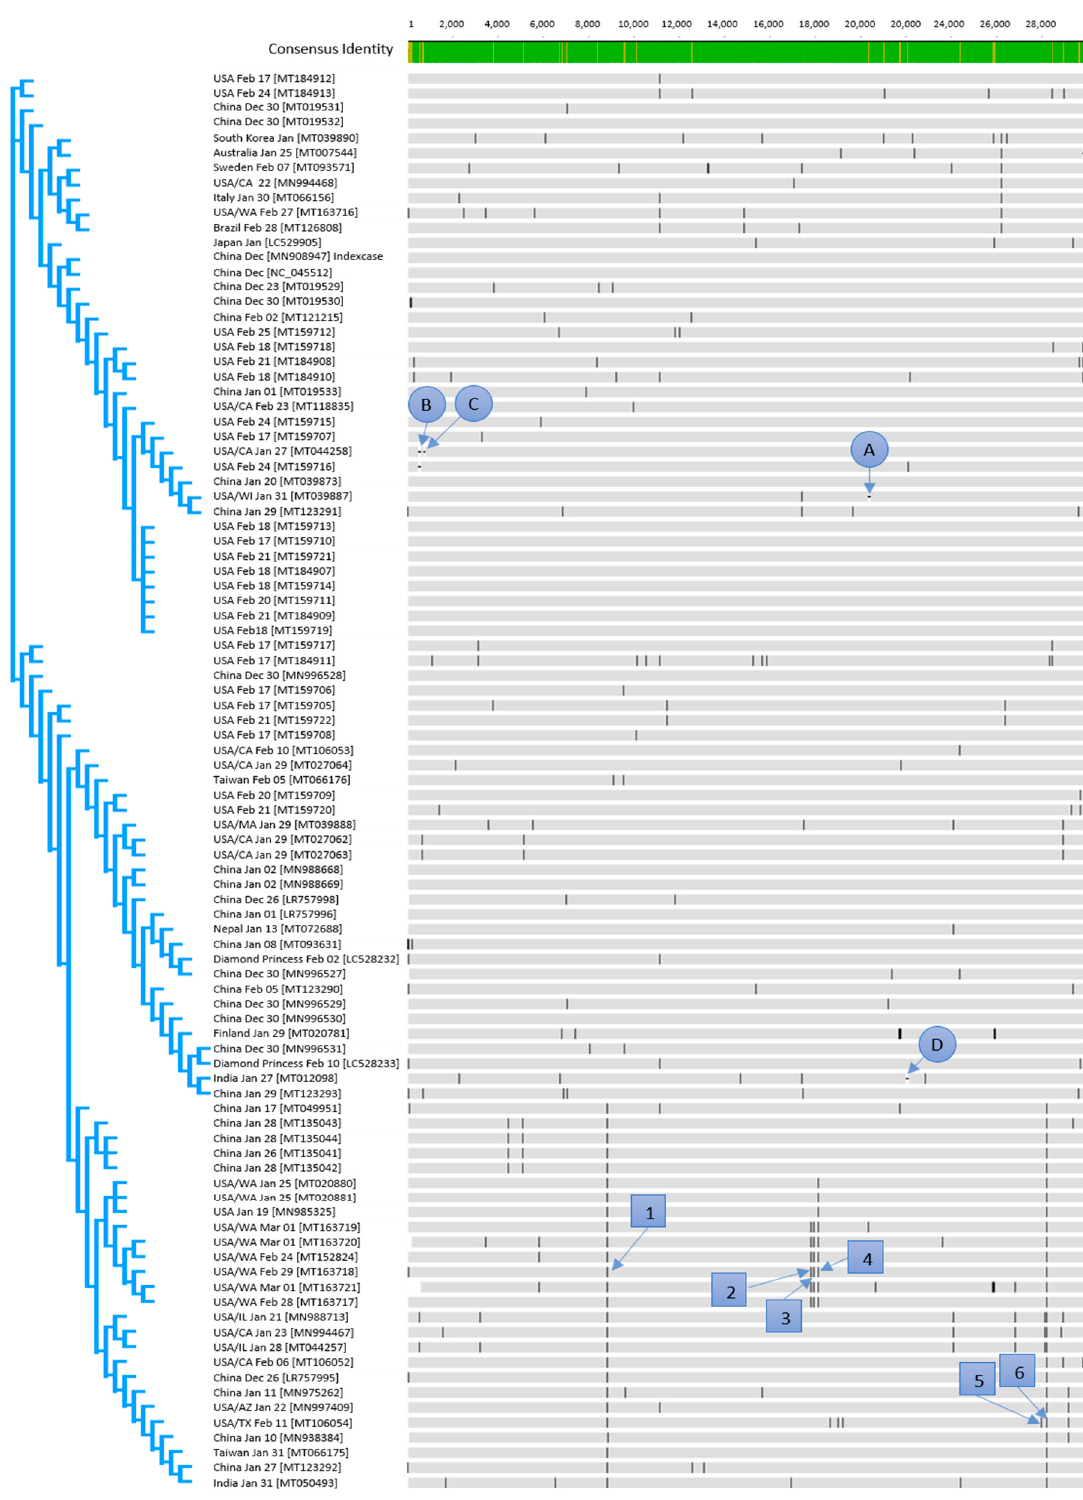
Figure 1. Alignment of all available sequences of SARS-CoV-2 from the NCBI database (March 16, 2020); numbers in squares are representing variants, letters in a circle are representing gaps.